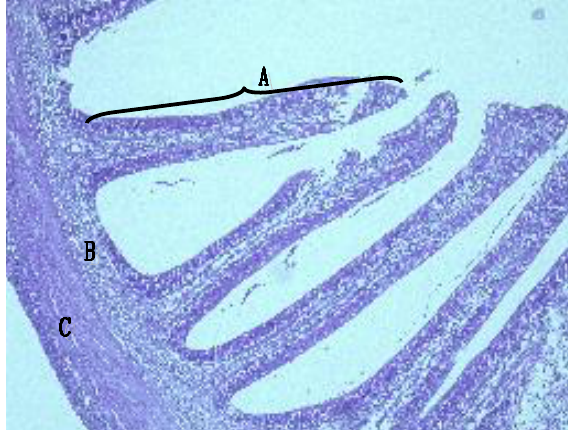
Figure, 8: Cross microscopic section of posterior portion of intestine of common carp, (A)fold, (B)submucosa, (C)Tunica muscularis, H & E stain (X40).